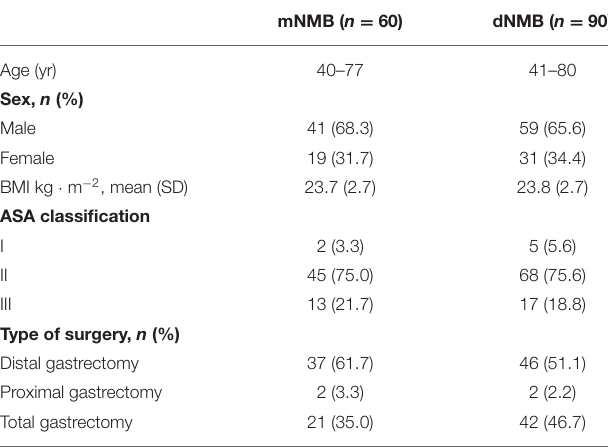
TABLE 1 | Baseline characteristics and intraoperative